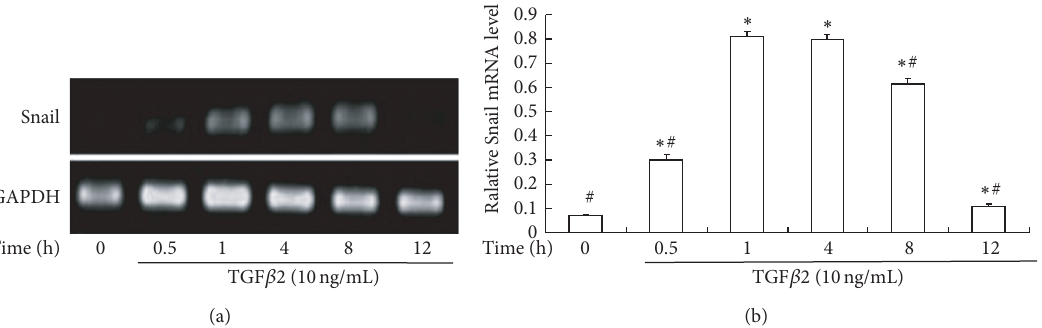
Figure 2: The time course of TGF 𝛽 2-induced expression of Snail mRNA. (a) Representative agarose gel electrophoresis images revealed TGF 𝛽 2-induced early expression of Snail. (b) The summary of triplicated experiments. ∗ 𝑃 < 0.05 compared with TGF 𝛽 2 ( − ) (0h). # 𝑃 < 0.05 compared with TGF 𝛽 2 (+)